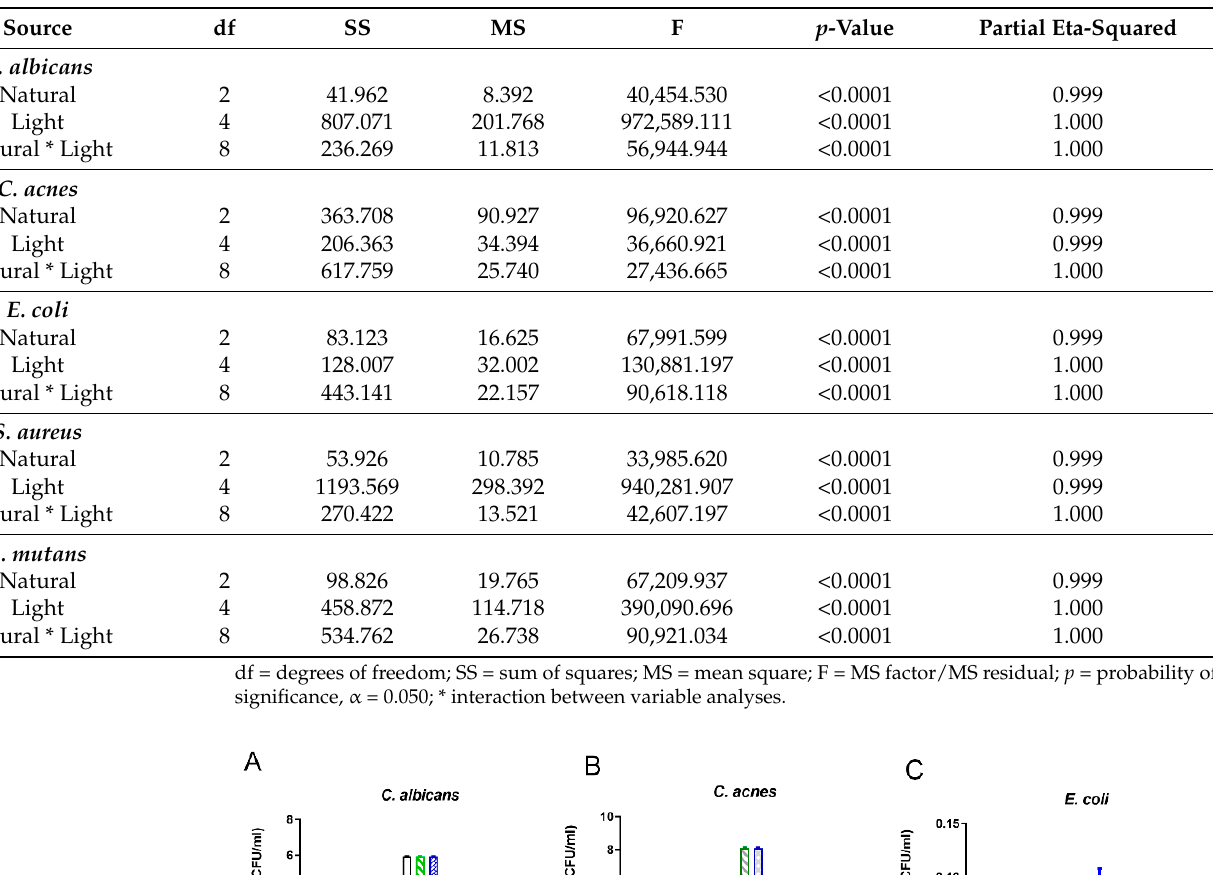
Table 3. Summary of two-way ANOVA results for bacterial viability in microbial suspensions. The analyzed variables were natural substances (“Natural”) and exposure to light (“Light”).